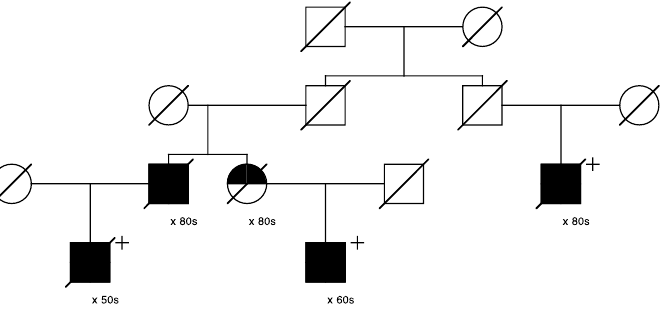
Figure 8. High-risk prostate cancer pedigree segregating a rare PTCH1 variant.